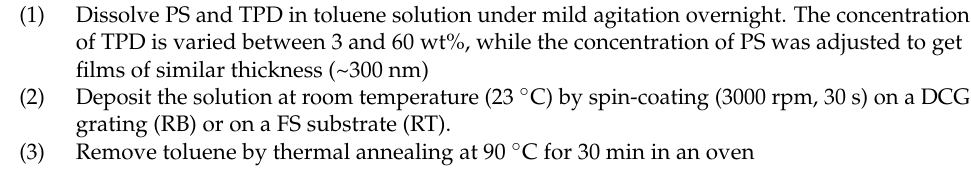
Table 2. Procedures for preparing the active